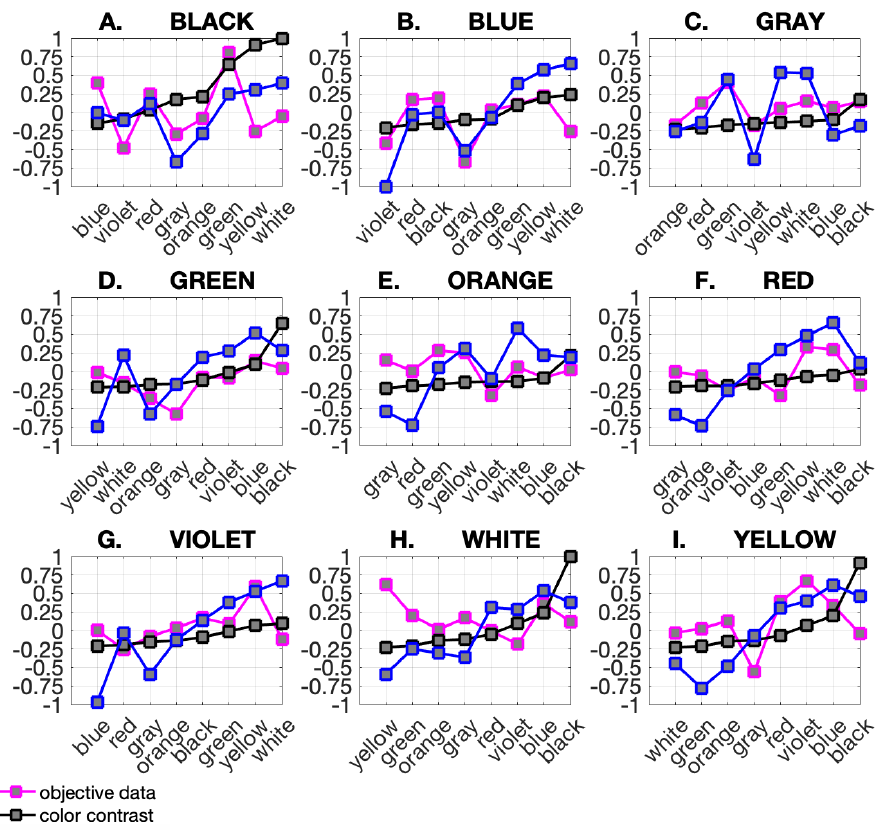
Figure 6. Color rankings for primary and secondary colors were developed based on ColoUR DB. The figure depicts the results for 9 tested colors: ( A – I ). The color ranking is arranged according to the level of user eye attraction. Each graph only applies to a single primary color, for example, ( A )—Primary color Black. On the X axis, there is a set of secondary colors. The Y axis represents normalized values obtained in the experiment. Each graph shows tree plots. The first one (magenta) shows objective data recorded by an eye-tracker. The second one (black) shows a contrast calculation for the same color pairs. The contrast was determined according to the WCAG standard presented in the Methods section. The third one (blue) shows subjective data coming from users’ responses obtained during the experiment, as presented in the Results